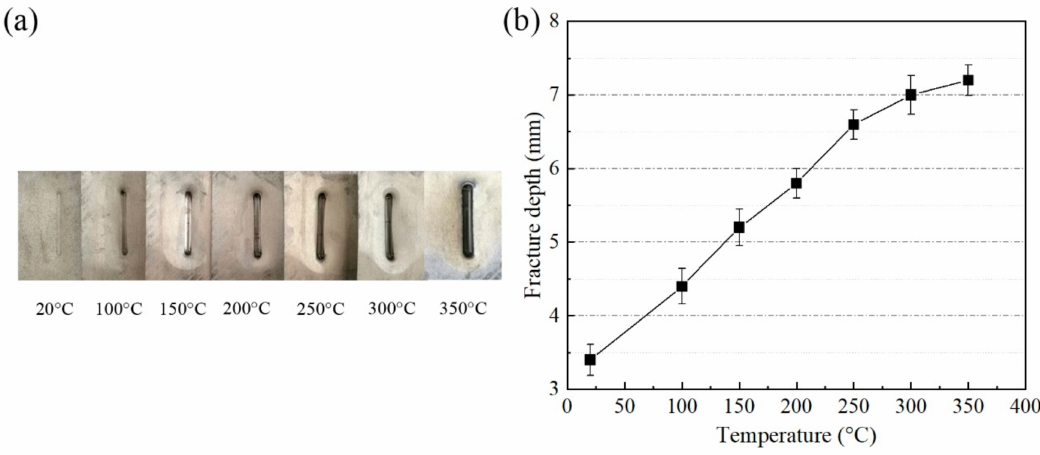
Figure 5. ( a ) Groove specimens and ( b ) fracture depth corresponding to different temperatures.